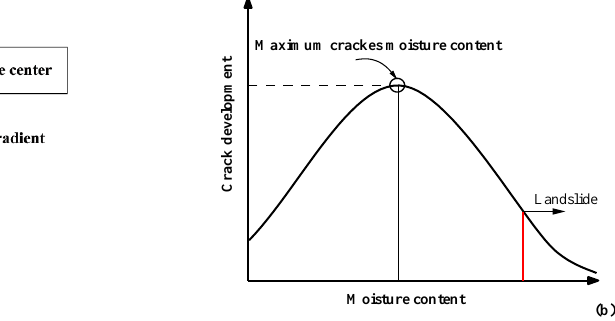
Figure 12. Crack development of the slope during freezing and thawing ( a ) formation process of freeze – thaw cracks; ( b ) relationship between cracks and moisture content in the freeze – thaw process.